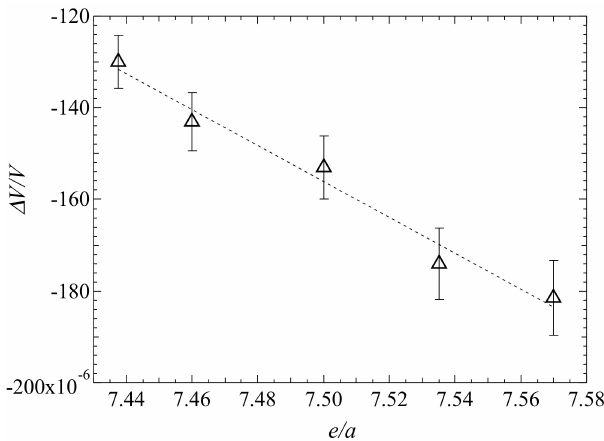
Figure 6. Forced volume magnetostriction ∆ V / V versus e / a at 5 T. The plots with e / a = 7.535 (Ni 2.02 MnGa 0.98 ) and e / a = 7.570 (Ni 2.04 MnGa 0.96 ) were obtained from Ref. [17] T. Sakon et al. Materials 2018 , 11 , 2115. MDPI, doi:10.3390 / 11112115. The dotted straight line is the fitting